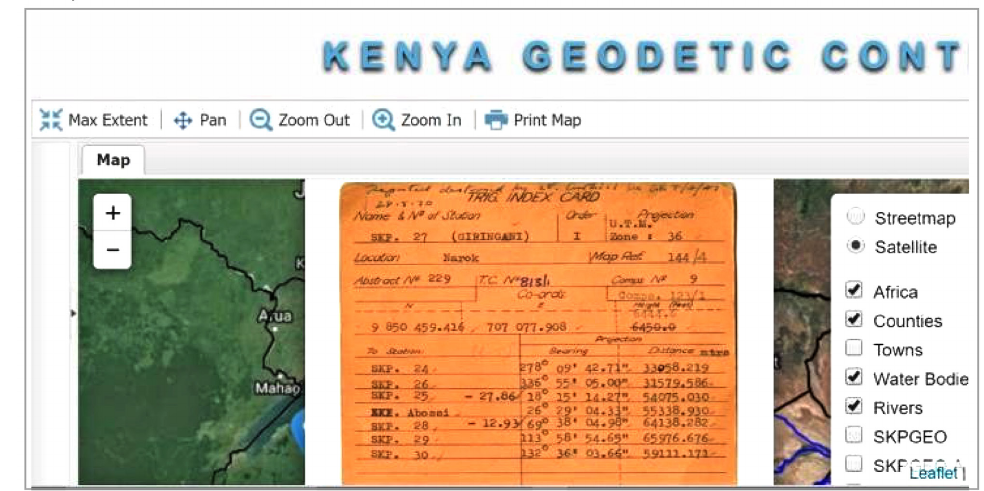
Figure 6. System application Interface with map visualization